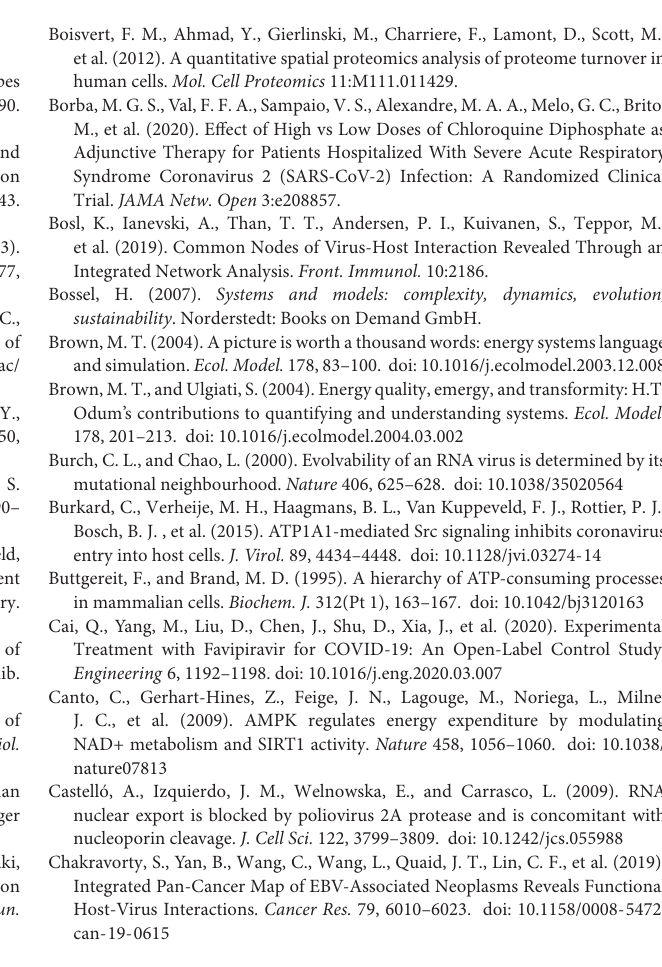
Supplementary Figure 1 | System dynamics of ( + )ssRNA virus–host interaction in response to initial viral load. Changes overtime of the values of each stock of the system diagrammed in Figure 1 (for the color code see at the bottom), expressed in ATP-eq: in absence of infection the system status was stationary (A) . Upon